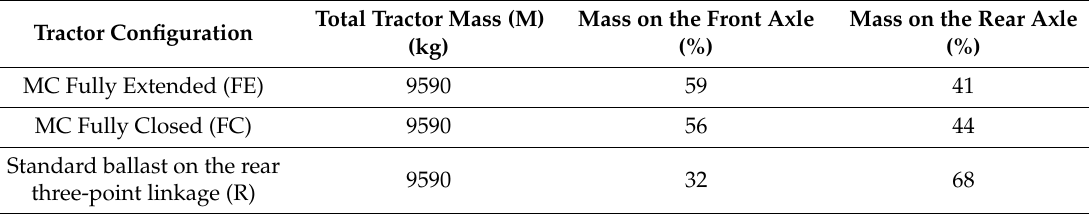
Table 2. Tractor static weight distribution over the axles in fully closed (FC), fully extended (FE) and standard ballast on the rear three-point linkage (R)